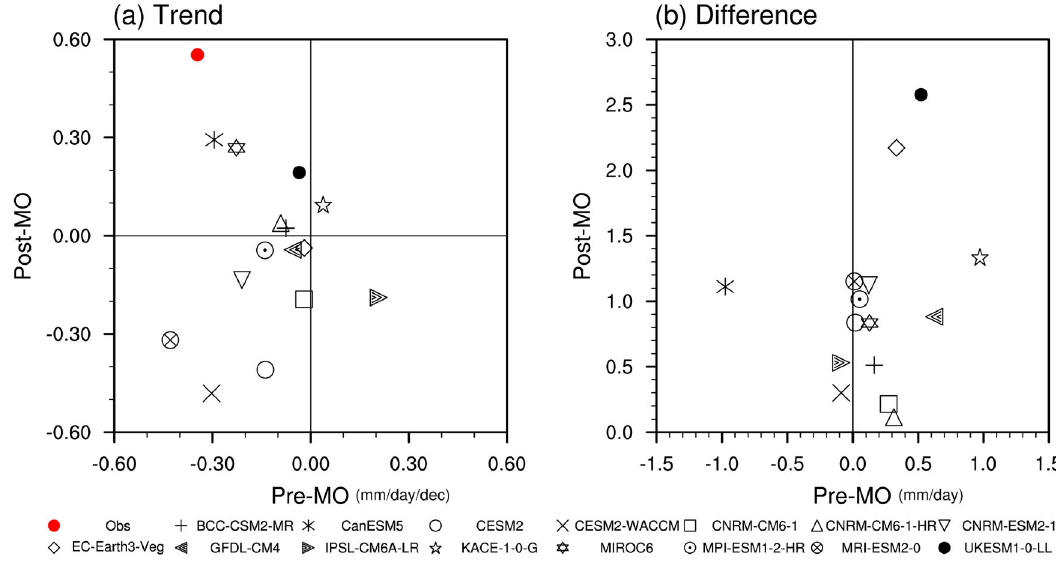
Fig. 5 Precipitation trends and projected precipitation changes in CMIP6 models. a Precipitation trends (mm/day/decade) over SC in the pre-MO and post-MO periods during 1979 – 2014 from 15 CMIP6 models (black markers), according to the speci fi c onset time of each model. Model names are listed at the bottom of the plot. The solid red dot is observed trends in 1979 – 2014. b Differences in precipitation (mm/day) over SC between the historical (1979 – 2014) and SSP5-85 (2065 – 2100) (2065 – 2100 minus 1979 – 2014) runs of the 15 CMIP6